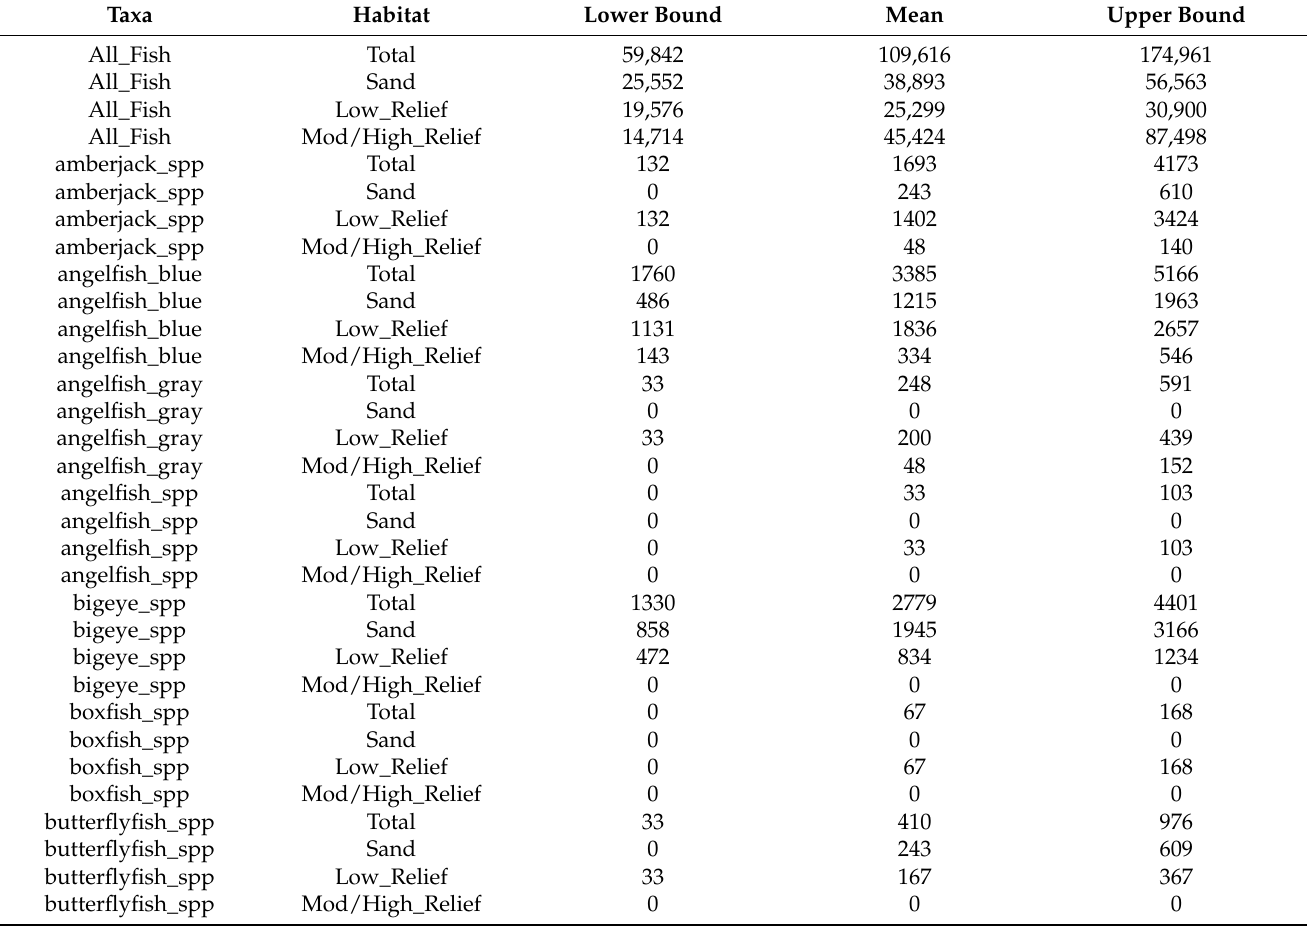
Table A3. Estimates of total abundance for all observed taxa within the portion of Elbow on the west Florida shelf that was mapped using a MBES. The calculated contributions of each habitat type (sand, low relief rock, and moderate to high relief rock) to the estimated total abundance are also shown. Extrapolations are based on the habitat-specific densities (Table A1 and Figure 13), and the area of each habitat based on the combined substrate and relief map (Figure 12). Upper and lower bounds represent the 95% bootstrap confidence